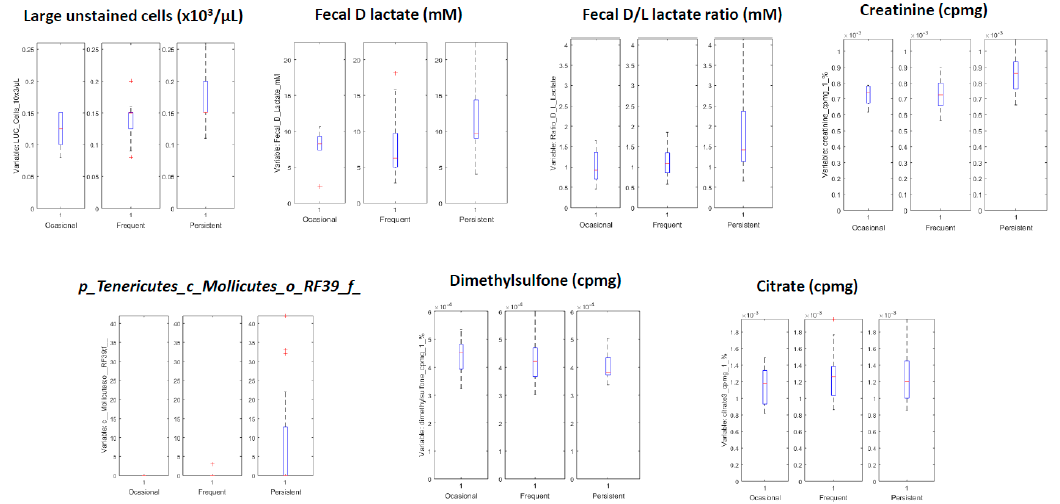
Figure 5. BOX plot representation of the variables associated with asthma severity (Occasional, frequent and, persistent). CPMG (Carr–Purcell–Meiboom–Gill) pulse sequence.